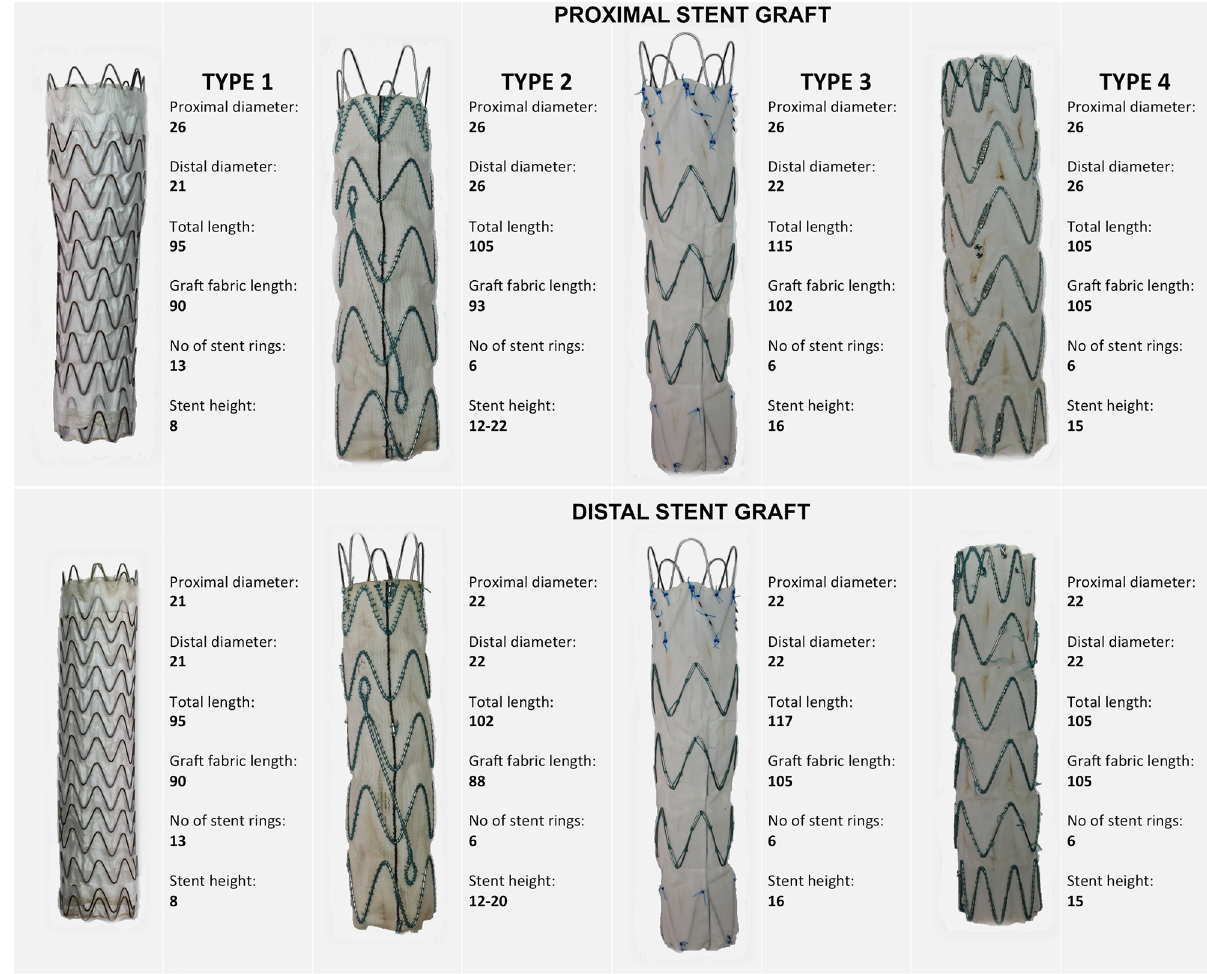
Fig 2. Description of the four types of stent grafts used for the experiments.